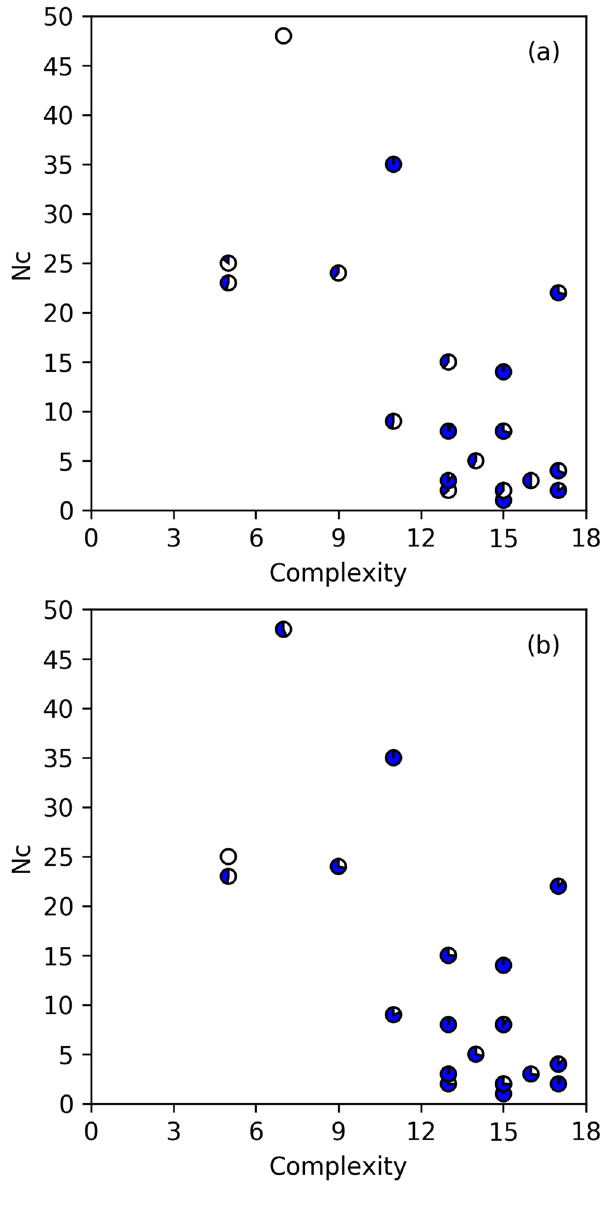
Figure 5. Complexity versus number of appearances (N c ) plots after parameter re-optimization based on training and validation data. Higher coverage indicates a better model as evaluated against the test data. Zero coverage represents ( a ) the highest RMSE, 1.27 ln(MV/m) and ( b ) the lowest PCC, 0.61. Full coverage represents ( a ) the lowest RMSE, 0.39 ln(MV/m) and ( b ) the highest PCC,